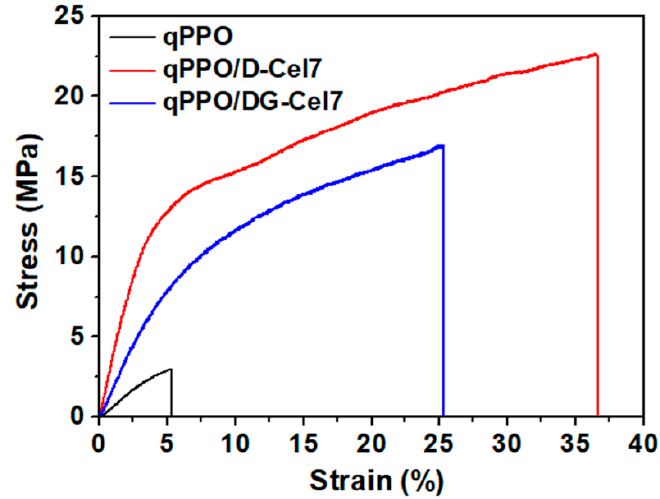
Figure 5. Tensile strength of membranes in a wet state.